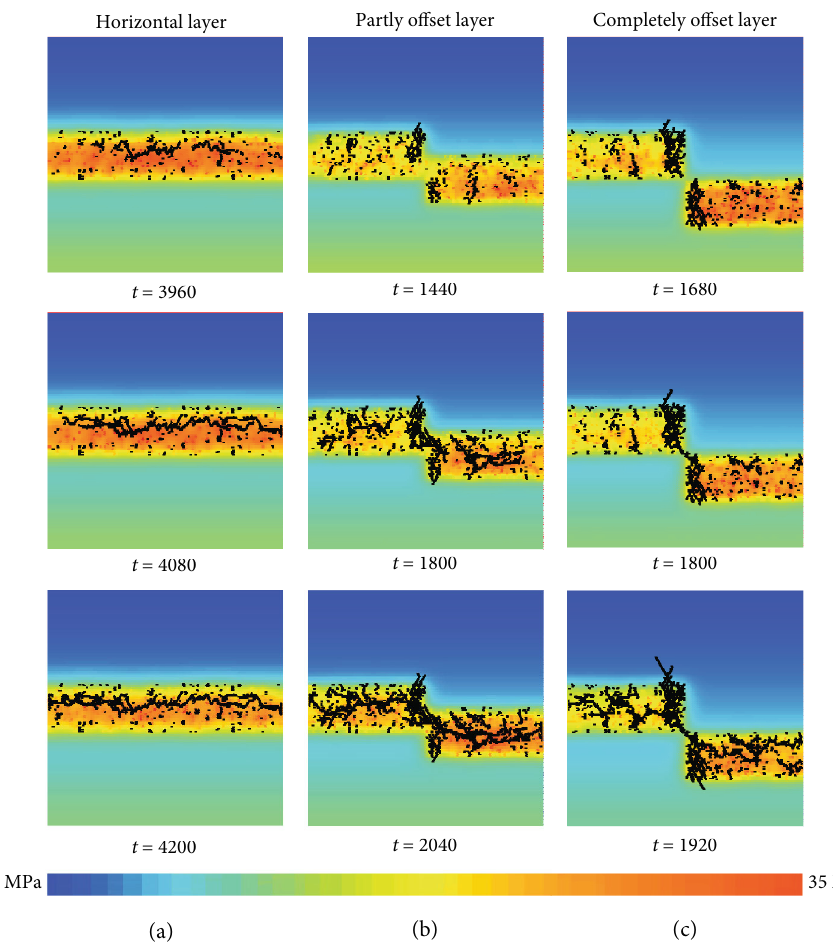
Figure 6: Fluid pressure (in color) and fracturing (in black) for scenario 3 with fl uid pressure increase in a horizontal layer that is faulted in (b) and (c). A horizontal layer shows a fracture evolution that is similar to scenario 2 with a semihorizontal branching fracture in the layer. Once the layer is faulted, the fl uid pressure gradients curve and form vertical to conjugate shear fractures at the layer tips where the fault is positioned. Fracturing within the layer is also more complicated because the layer is dilating in two dimensions in the vertical as well as the horizontal direction. This leads to stronger brecciation of the